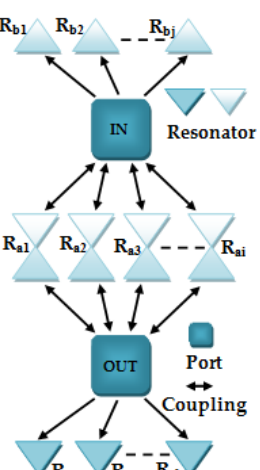
Figure 13. General equivalent circuit model of a 3D FSS with multiple resonators or modes